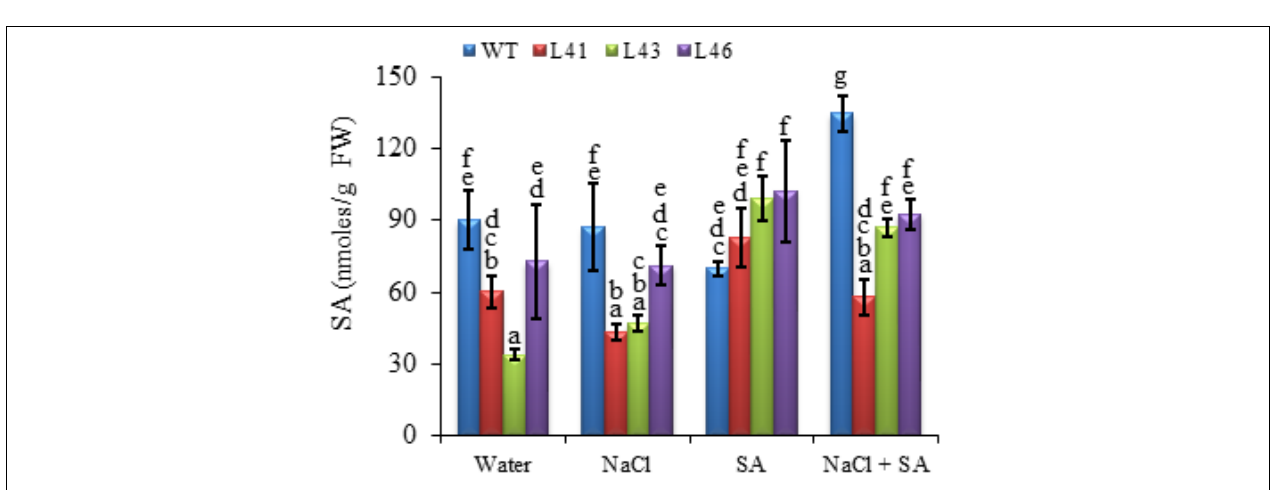
FIGURE 7 | Activity of (A) CAT and (B) SOD in WT and JcWRKY transgenic lines (L41, L43, and L46) at different NaCl, SA and combined stress treatments. Values are represented as mean ± SD ( n = 3) and marked with different alphabets to indicate significant difference at P ≤ 0.05 probability.